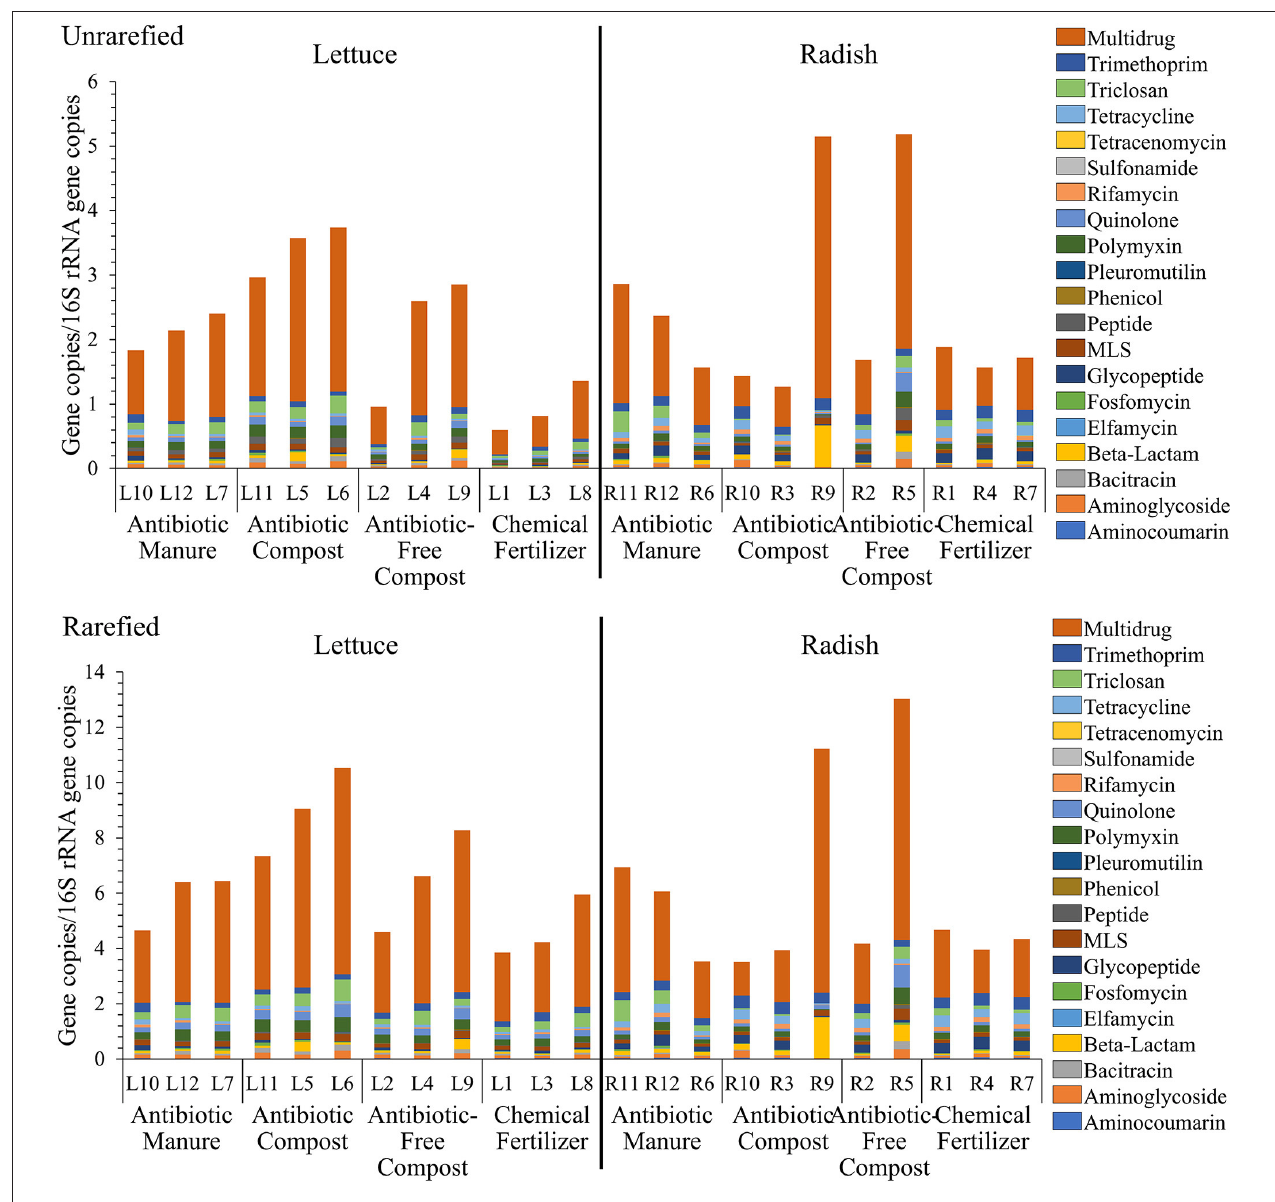
FIGURE 3 | Relative abundance of total DNA sequence reads annotated as ARGs, as aligned to CARD v1.2.1 (e-value < 1e − 10, 80% identity, ≥ 25 amino acids), and normalized to 16S rRNA reads, as described by Li et al. (2015). (top) Unrarefied, no chloroplast removal: 20 different antibiotic resistance classes were represented, normalized to the number of 16S rRNA gene copies. Kruskal-Wallis indicated significant effects of amendments for lettuce in terms of total ARGs ( p = 0.0329); Fosfomycin ( p = 0.0415); Multidrug ( p = 0.0434); Peptide ( p = 0.0455); Polymyxin ( p = 0.0237); and Quinolone ( p = 0.0455) classes. No differences across radishes noted except the Tricloson class ( p = 0.049). (bottom) Rarefied to 11,800,000 reads per sample and excluding chloroplast 16S rRNA genes. Twenty different antibiotic resistance classes were represented across lettuce treatments. Kruskal-Wallis indicated no significant effects across amendment conditions, except Fosfomycin ( p = 0.043) and Polymyxin ( p = 0.043) for lettuce and Triclosan ( p = 0.049) for